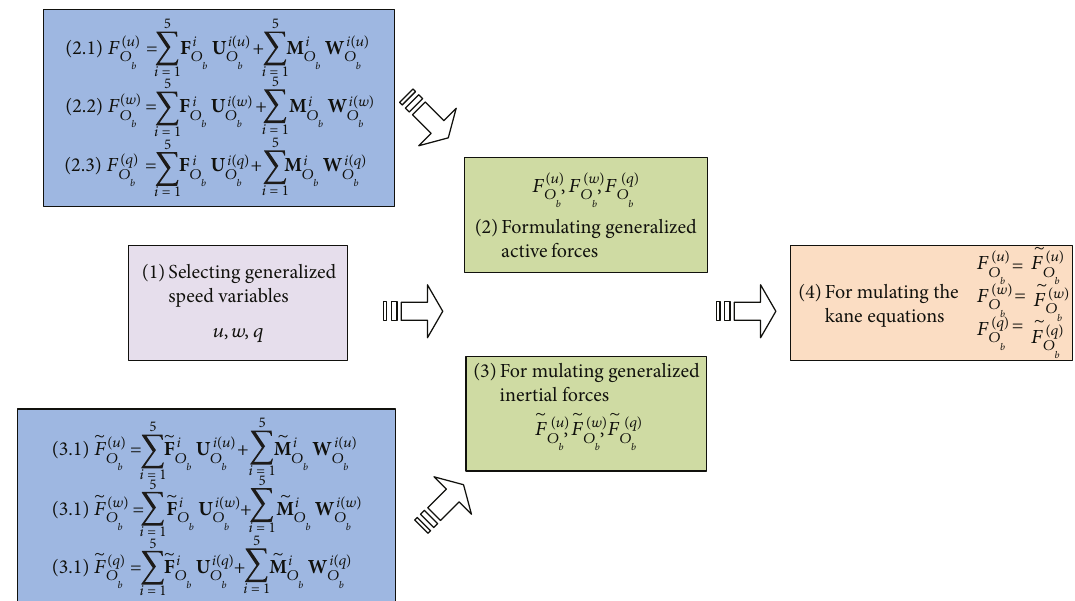
Figure 3: Kane modeling